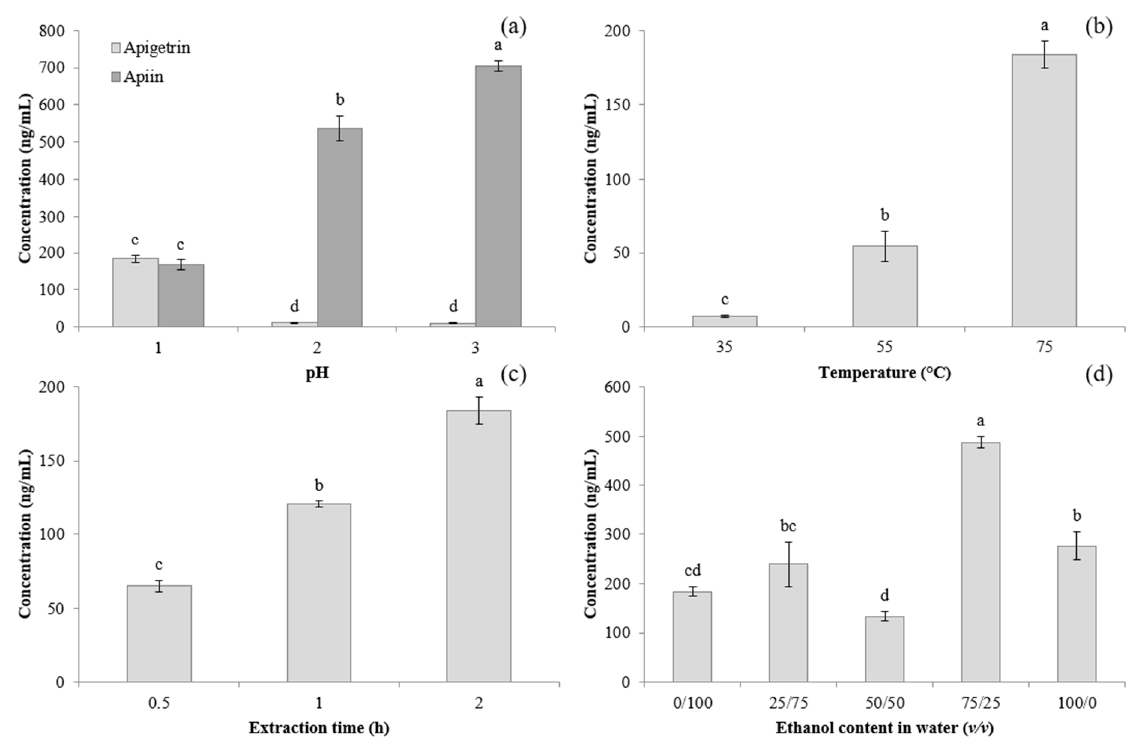
Figure 1. Extraction optimisation of apigetrin: ( a ) effect of pH in water at 75 °C for 2 h; ( b ) effect of temperature in water at pH 1 for 2 h; ( c ) effect of extraction time in water at pH 1 and 75 °C; ( d ) effect of ethanol content in water at pH 1 and 75 °C for 2 h. Different letters indicate a significant difference ( p < 0.05).